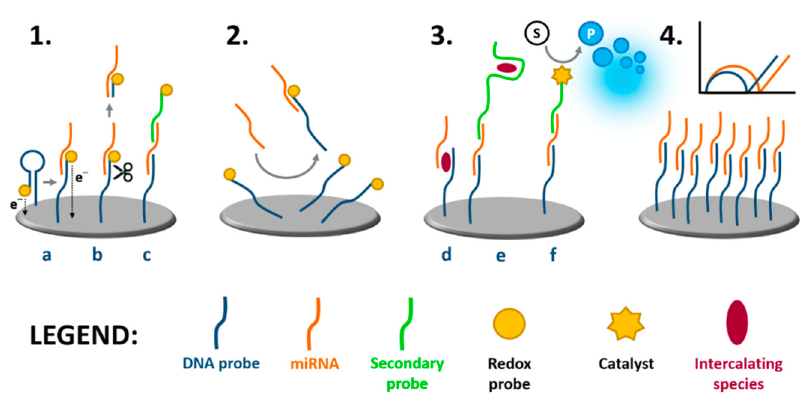
Figure 5. Schematic presentation of different configurations of miR (orange) detection platforms, based on hybridization with a complementary sequence (probe, blue). ( 1 ) Interaction of miR analyte with a redox-labelled complementary probe on an electrode surface, while ( a ) probe is a hairpin which unfolds upon binding, leading to a decreased signal; ( b ) a product is specifically cleaved, leading to a decreased signal, ( c ) a secondary probe (green) is used for the detection, leading to a signal generation. ( 2 ) Hybridization of miR with an unlabelled probe leads to desorption of a non-covalently adsorbed probe from an electrode surface, leading to a decreased signal. ( 3 ) A signal is generated due to introduction of an additional component, e.g., by an intercalating species via ( d ) a direct or ( e ) a template-directed way; ( f ) a signal is generated using a catalyst molecule. ( 4 ) A label-free detection, using for example electrochemical impedance spectroscopy and a charge transfer resistance parameter as an evaluated signal; inset: Nyquist plots for a bioreceptive layer and after a biorecognition/hybridization took place. Redrawn with permission from ref. [127], Copyright (2015), Royal Society for Chemistry.